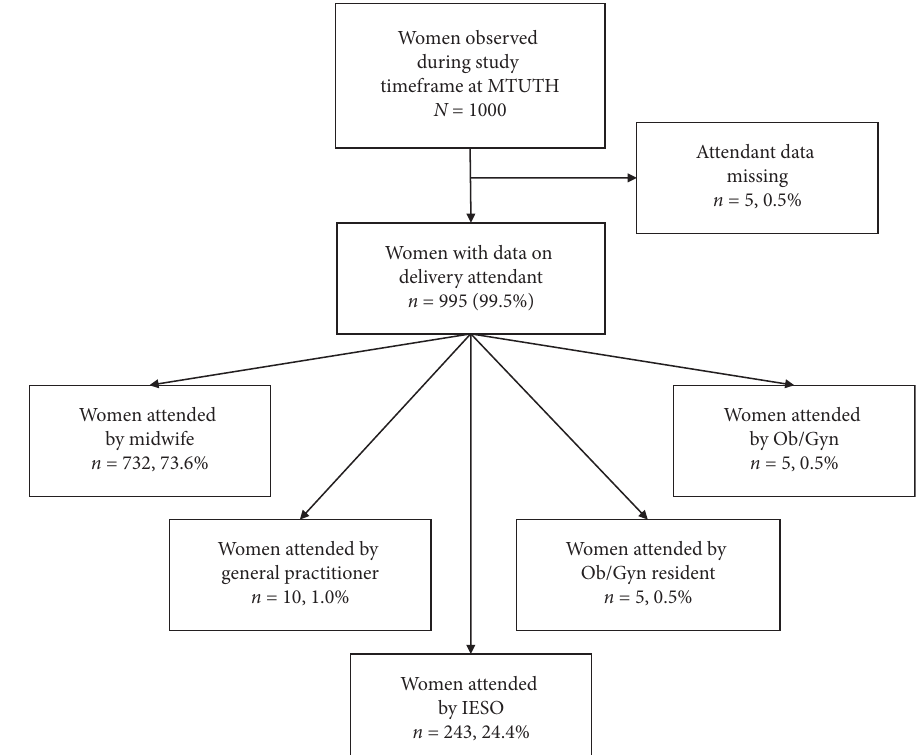
Figure 1: Study population by